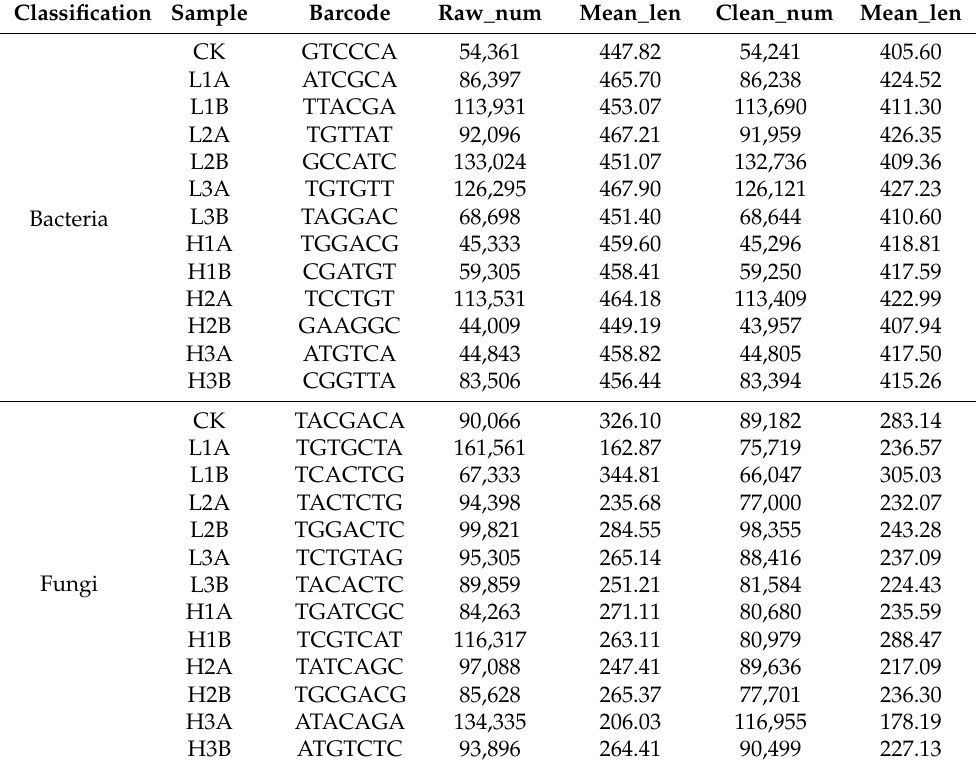
Table 1. Bacteria and fungi information statistics.